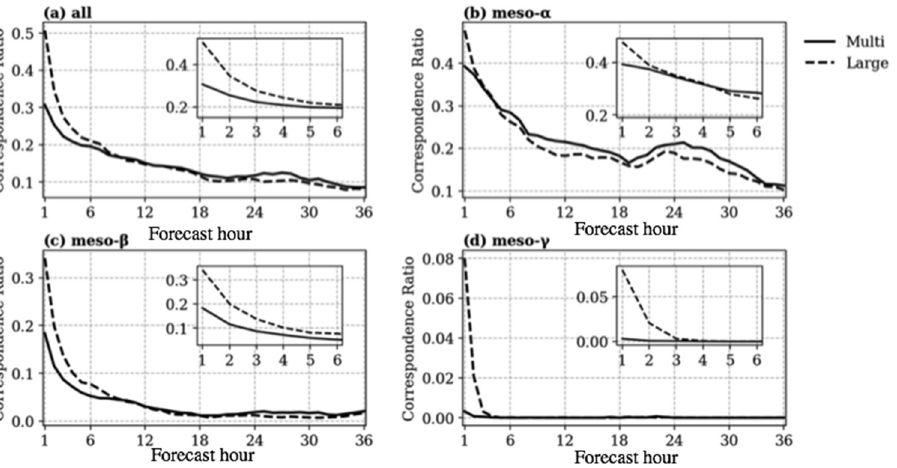
Figure 9. Distributions of correspondence ratio (CR) of MULTI (solid) and LARGE (dashed) for (a) the full field, (b–d) meso-alpha, meso-beta, and meso-gamma subfields aggregated over 25 cases. The inset within each subfigure highlights the CR distributions for the first 6 h forecasts.